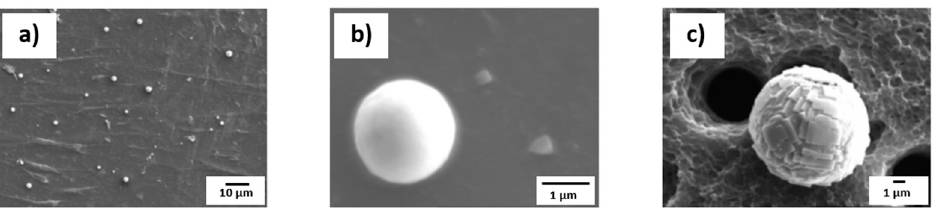
Figure 4. SEM image of the surface filter and the inclusions after extraction of a Fe-20 wt.% Cr alloy using 10% AA, where ( a ) and ( b ) are particles obtained under a charge of 300 coulomb and ( c ) was a particle obtained under a charge of 600 coulomb [66]. The length scales have been updated in the current paper. Copyright © 2009 Verlag Stahleisen GmbH, Düsseldorf.